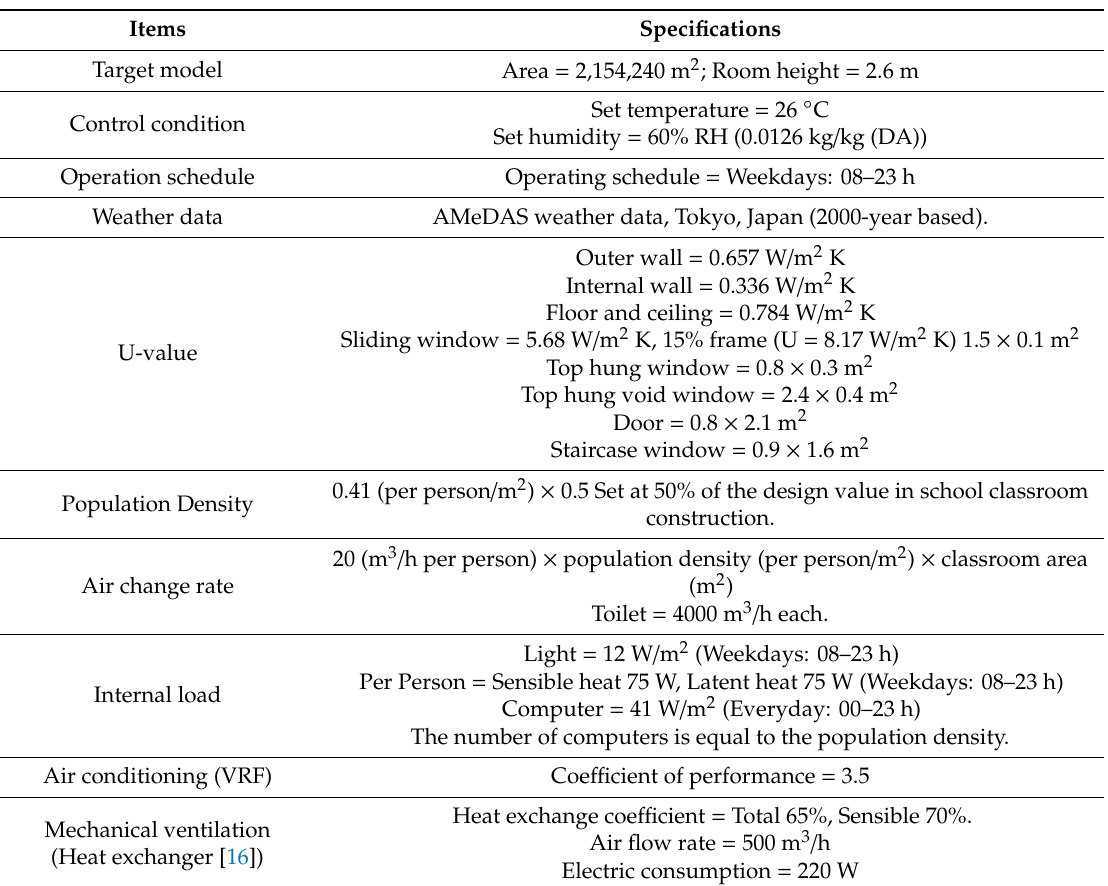
Table 3. Simulation condition and building details.